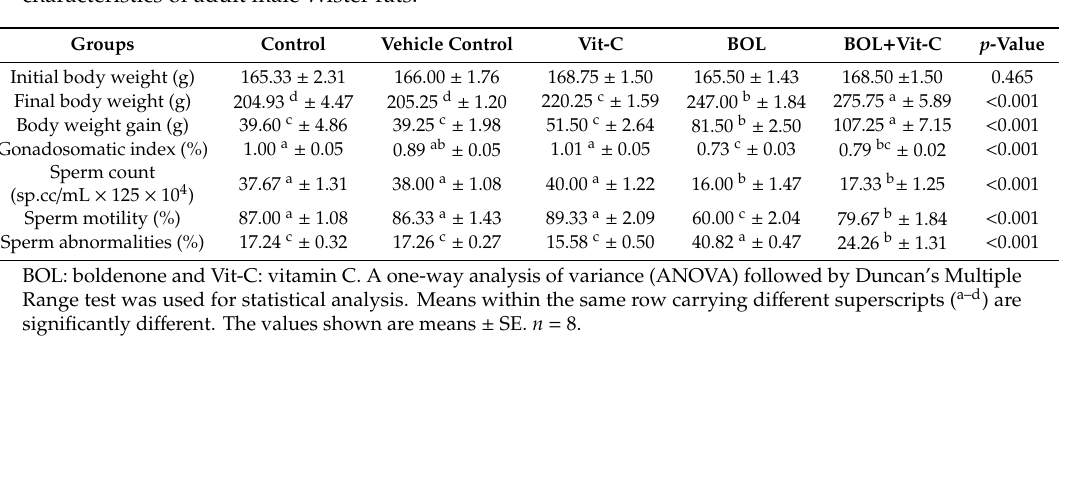
E ff ect of boldenone (5 mg / kg bwt / once a week, eight weeks) and / or vitamin C (120 mg / kg b.wt / daily, eight weeks) treatment on body weight change, gonadosomatic index, and sperm characteristics of adult male Wister rats.